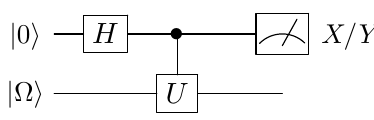
FIG. 8. Hadamard test circuit, which computes the real and imaginary parts of the overlap matrix, where | (cid:17) (cid:3) denotes the system and the top qubit is the ancilla. Here U = e − itH